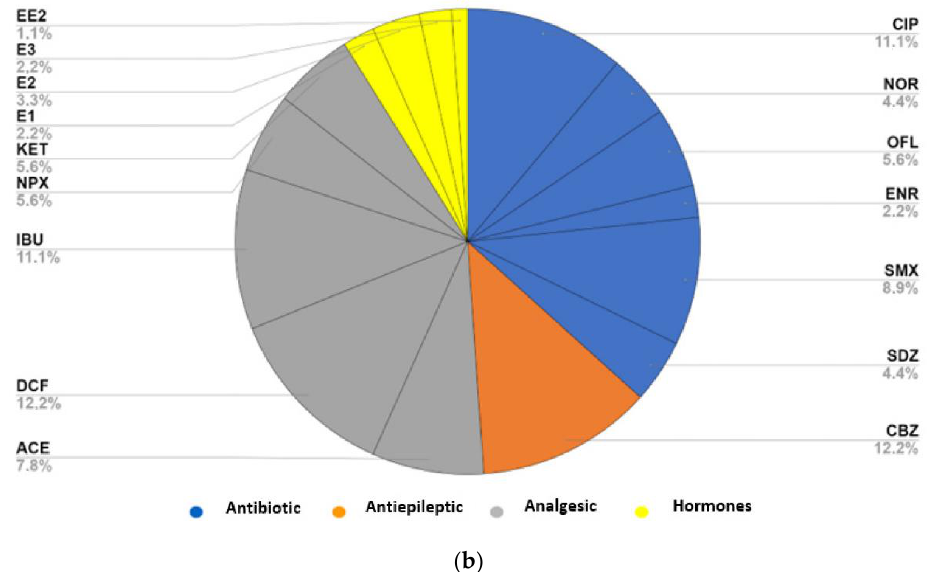
Figure 4 . ( a ) Main therapeutic categories and ( b ) types of pharmaceuticals most frequently detected in wastewater. The data in Table 4 show the percentages of pharmaceutical removal in terms of re- moval techniques based on physical treatment methods, where reverse osmosis stands out, with removal rates ranging from 96% to 99.9% for pharmaceutical products such as OFL, SMX, CBZ, and DCF in studies with a pre-experimental design [48]. On the other hand, Farrokh Shad et al. (2019), in a study with a quasi-experimental design, reaffirmed the high removal of this technique regarding the aforementioned contaminants, along with the complete removal of hormones such as E1 and E2 [29]. Table 4. Removal of pharmaceuticals by physical treatment methods.